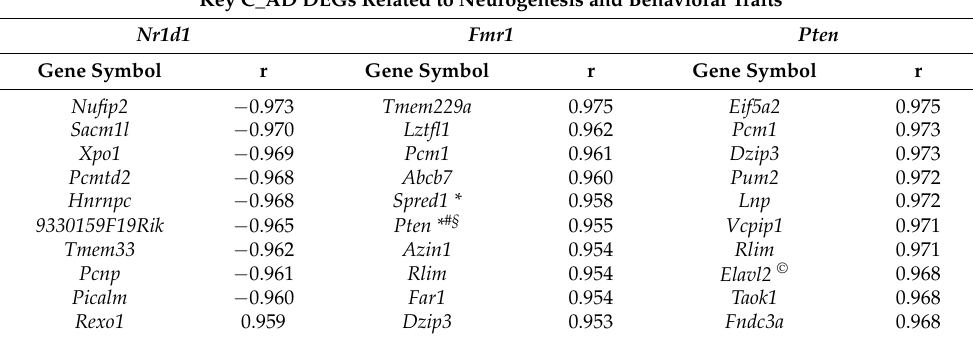
Table 7. Top 10 C_AD DEGs whose expression correlates with the expression of key hippocampal DEGs associated with neurogenesis and behavioral traits of experimental male mice. Key C_AD DEGs Related to Neurogenesis and Behavioral